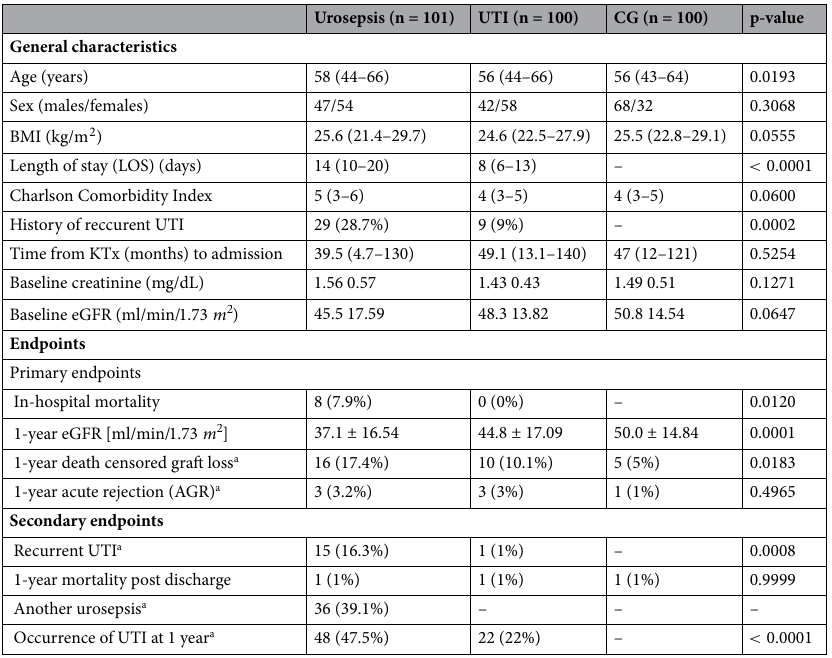
Table 1. Baseline characteristics of the study groups and endpoints occurring during follow-up. a Calculated after censoring for death at 1